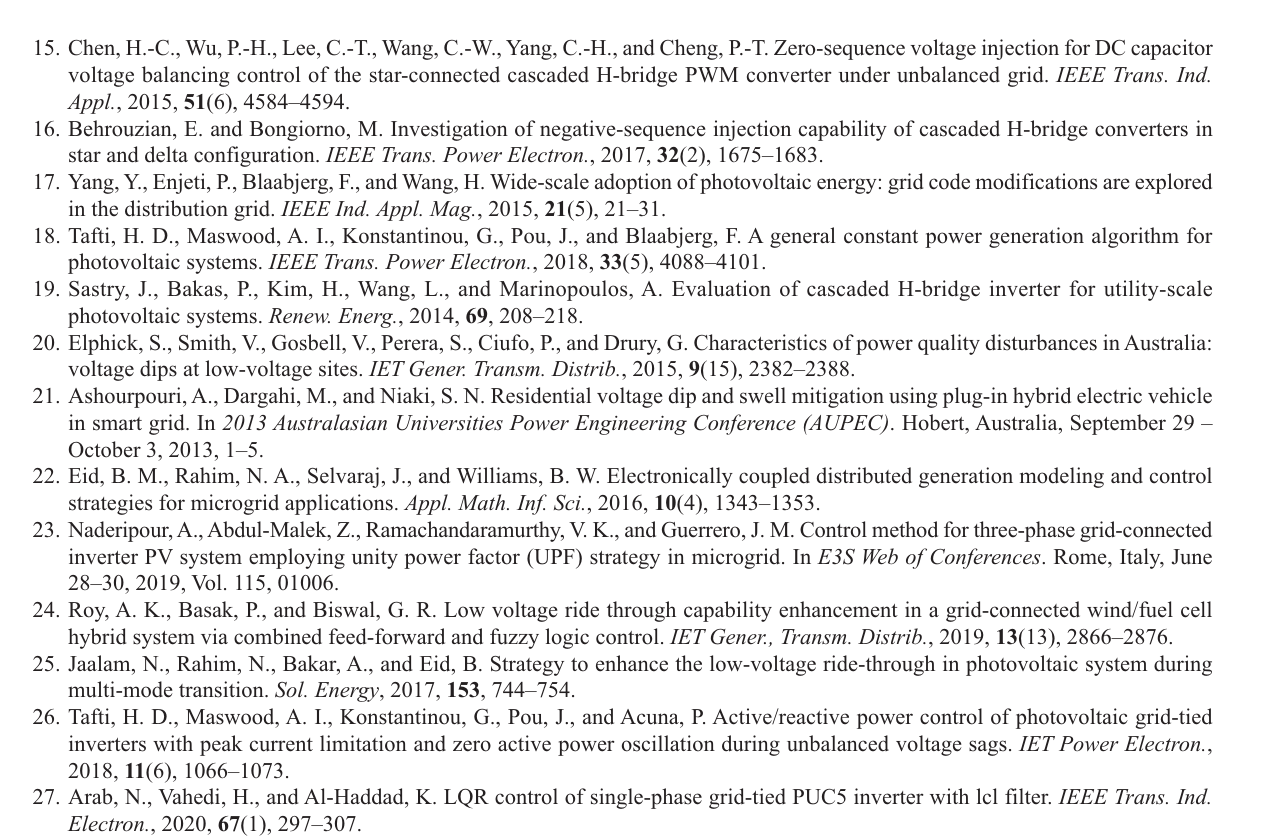
Fig. 15. Sine Pulse Width Moduulation to generate smooth sine at tthe output of the inverter.